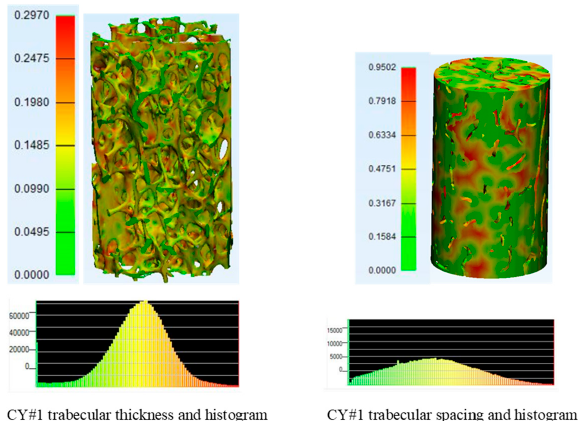
Figure 8. Trabecular thickness and trabecular spacing colored maps and histograms for cylindrical bone sample CY#1.